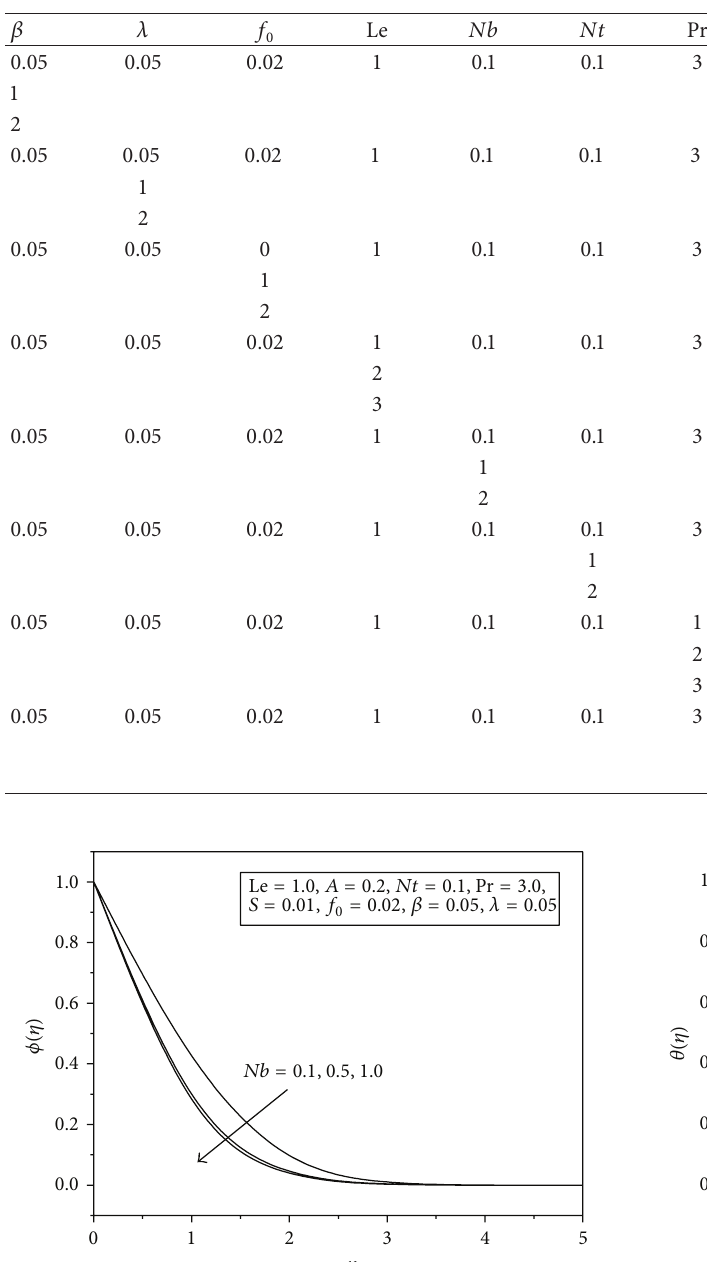
Table 4: Values of skin friction coefficient 𝑓 󸀠󸀠 (0) , Nusselt number −𝜃 󸀠 (0) , and Sherwood number −𝜙 󸀠 (0) for different values of the physical parameters with 𝐴 = 2.0 .